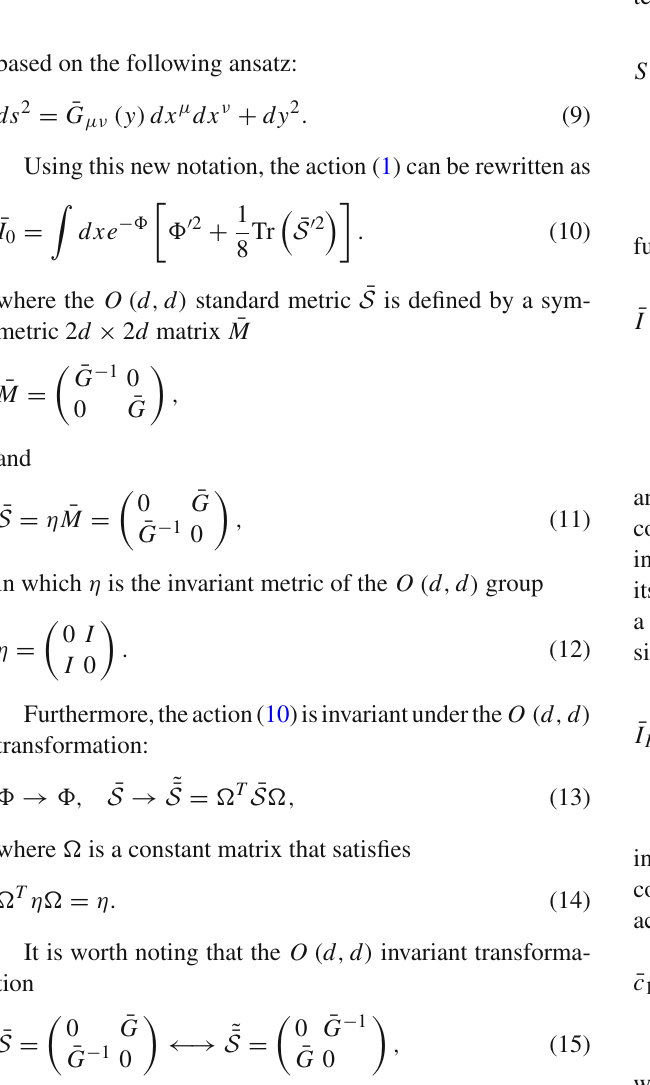
Fig. 1 Hubble-likeparameters ¯ H vs.coordinateofdimension y offour solutions (we set d = 4 in this